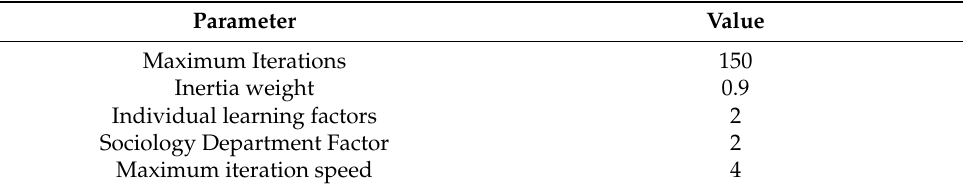
Figure 15. The sensitivity of three algorithm model parameters. The random forest model is shown in the green bar, the back propagation model is shown in the orange bar, the Naïve Bayes model is shown in the blue bar. Table 3. The boundary and external conditions of PSO algorithm.